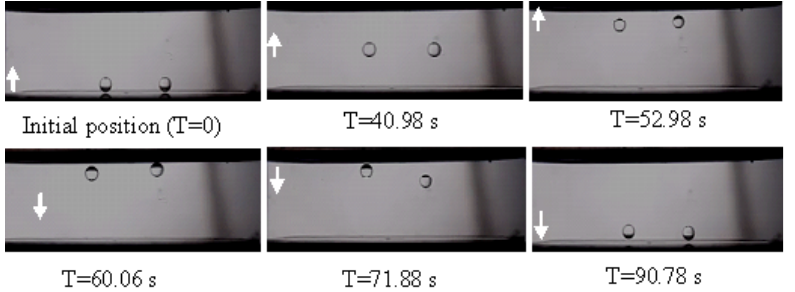
Figure 2. Sequential images showing the motion of a pair of water drops subjected to a D.C. Electric field E o = 1 . 1kVcm − 1 for drop radius